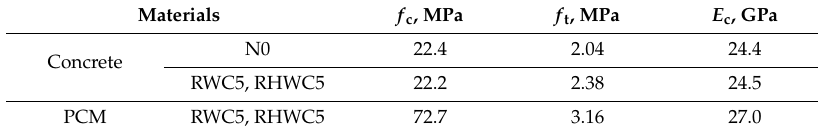
Table 3. Material properties of concrete and PCM.